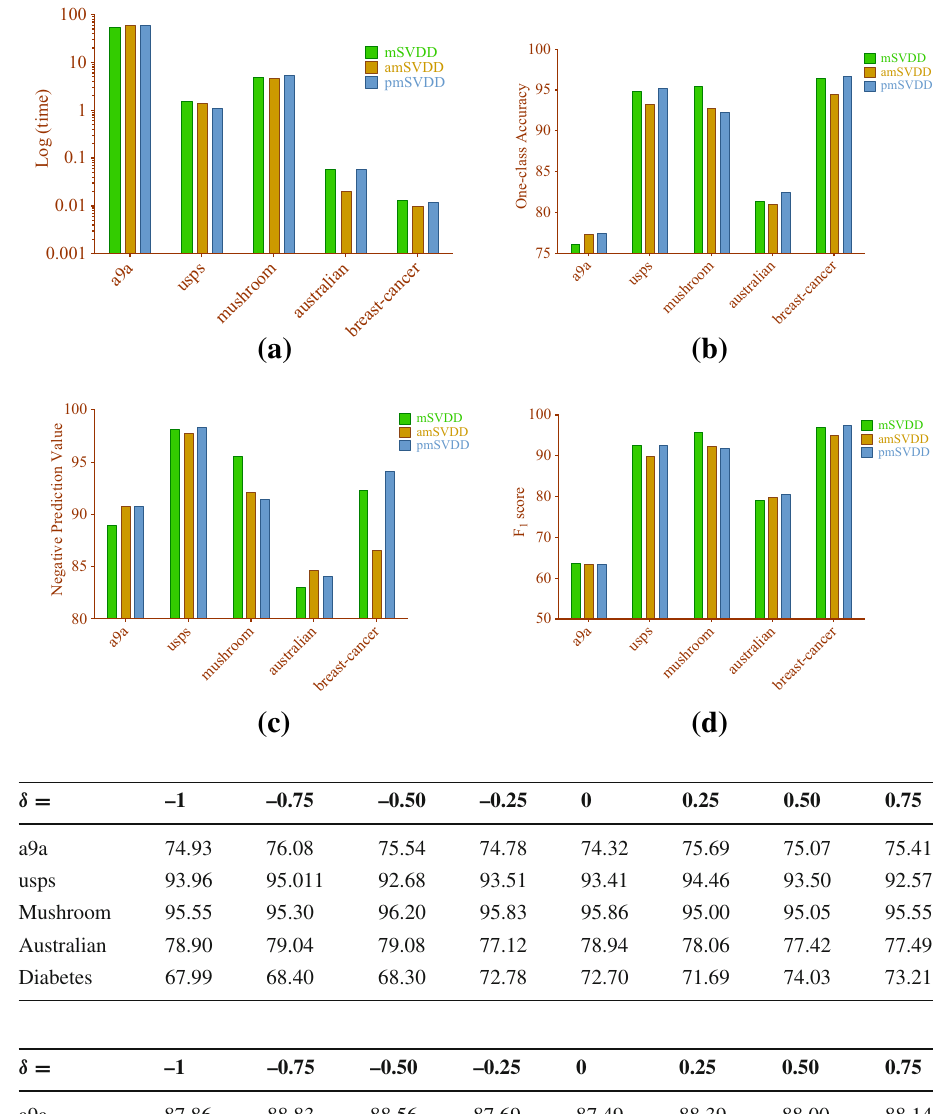
prediction value when parameter δ is varied